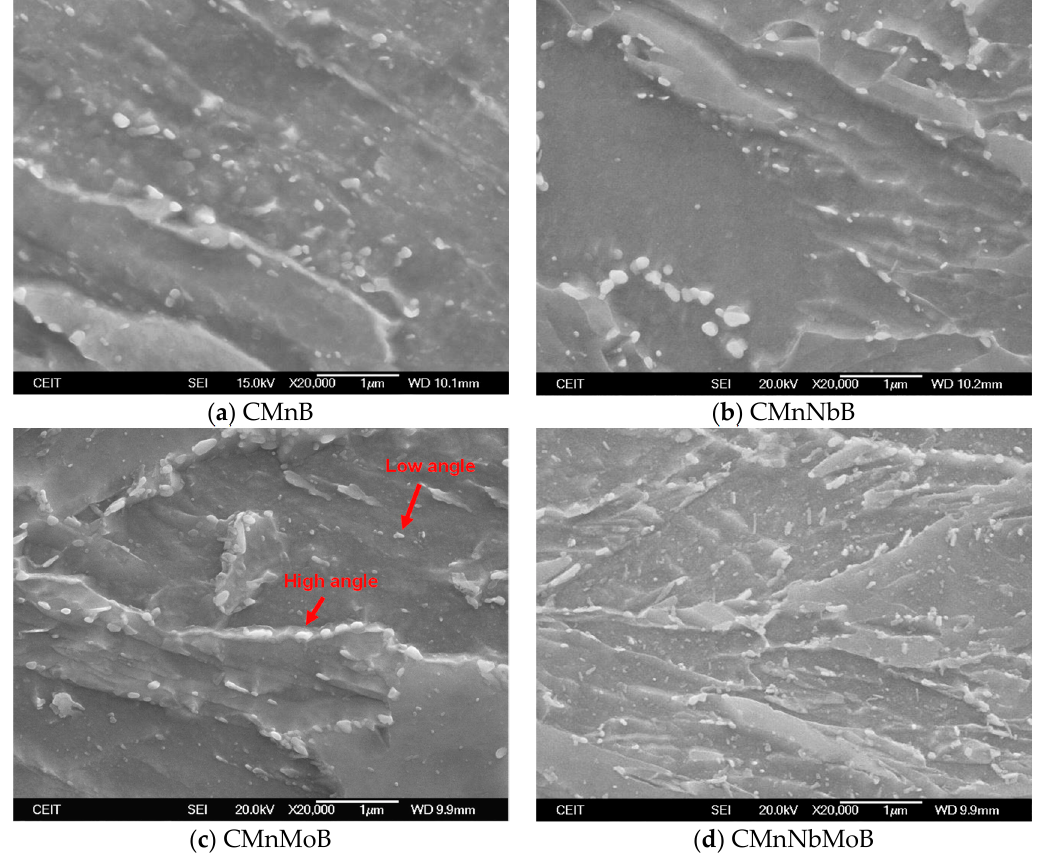
Figure 7. Field-emission gun scanning electron microscopy (FEGSEM) micrographs corresponding to ( a ) CMnB, ( b ) CMnNbB, ( c ) CMnMoB and ( d ) CMnNbMoB steels.